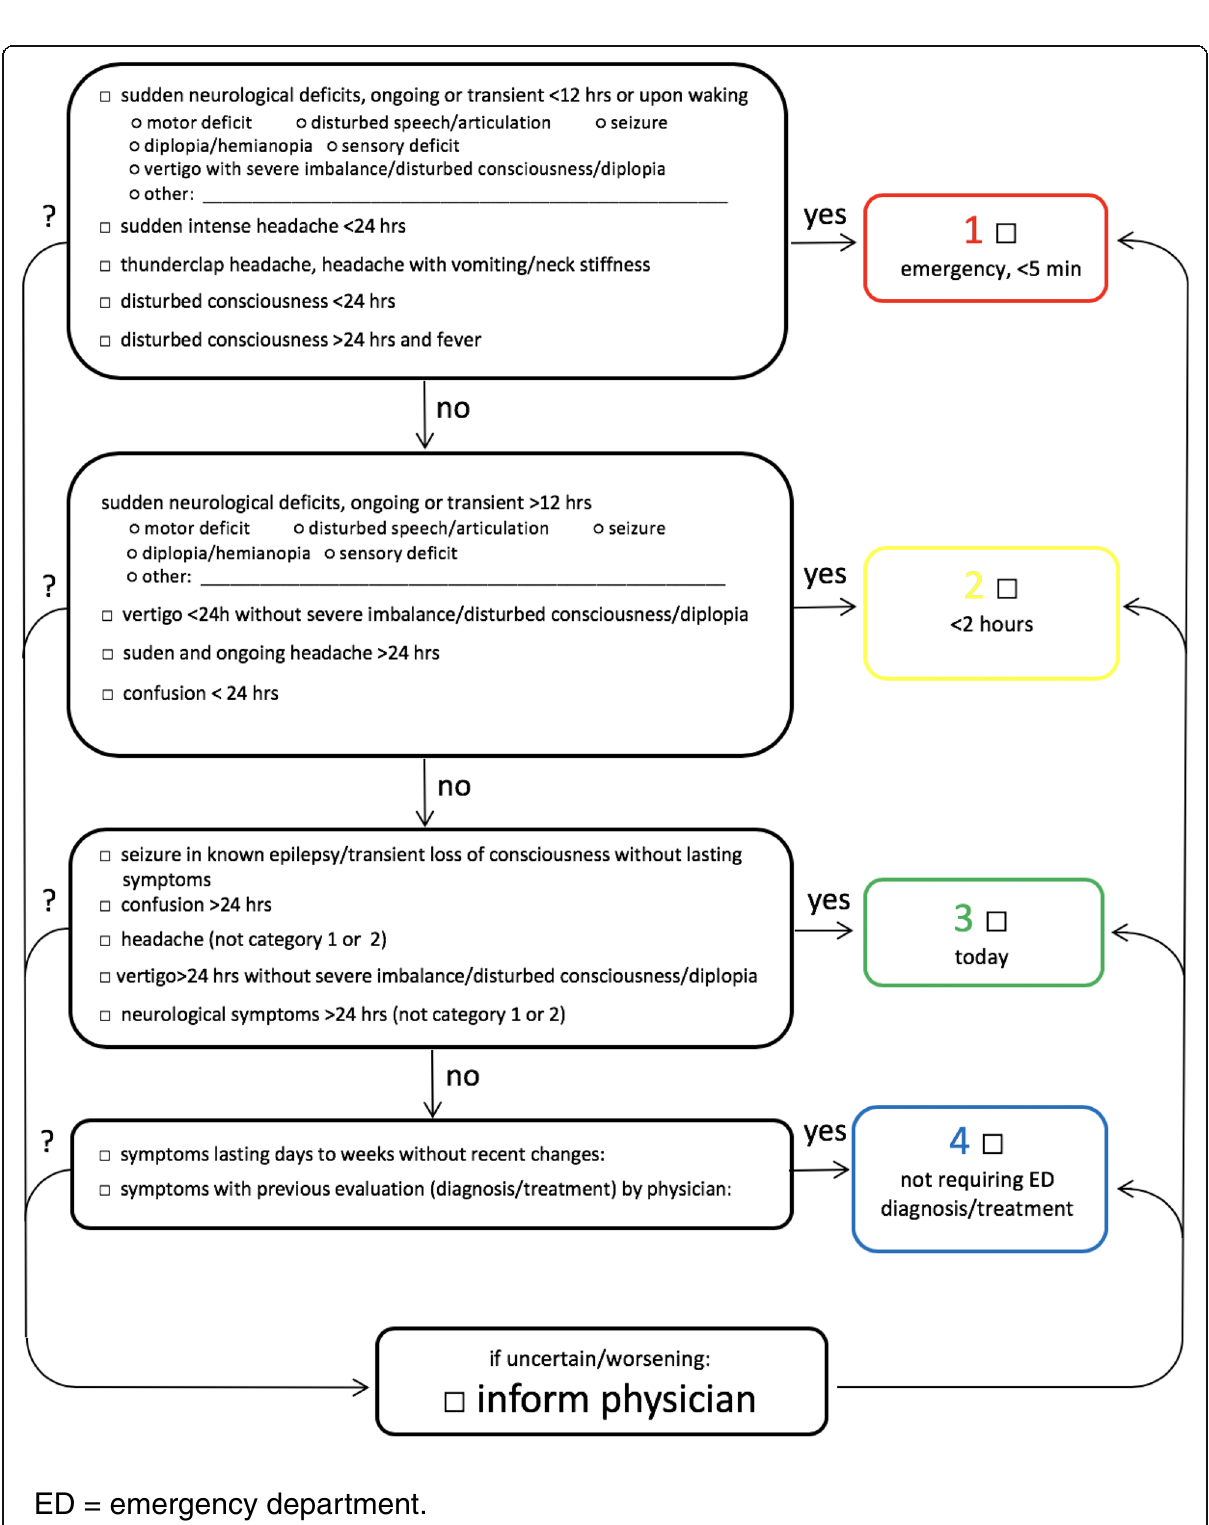
Fig. 1 The Heidelberg Neurological Triage System (HEINTS). ED = emergency